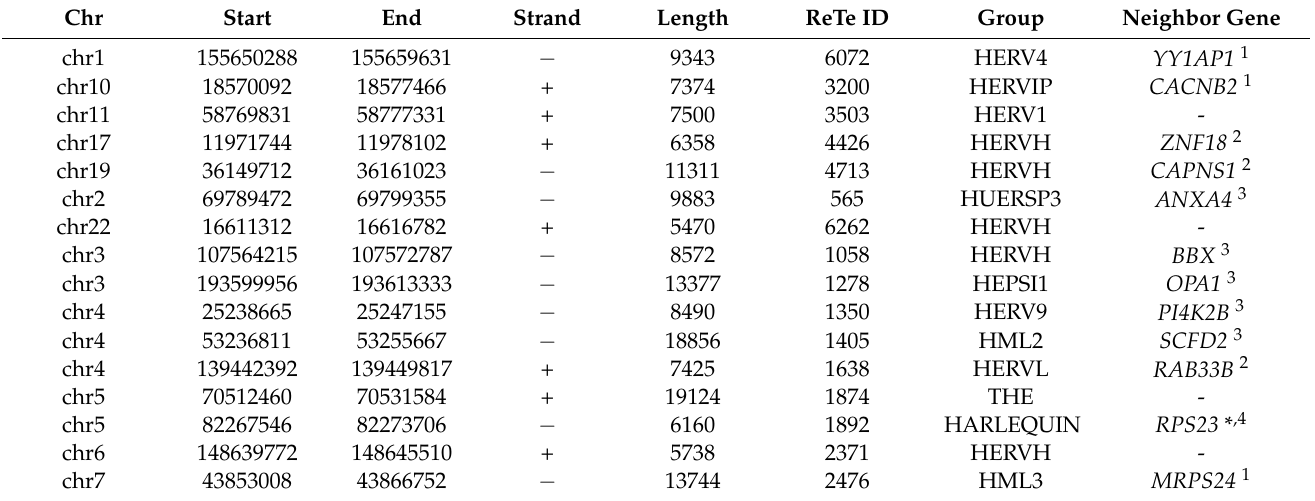
Table 3. Description of the 16 ReTe proviruses differentially expressed after all vaccine